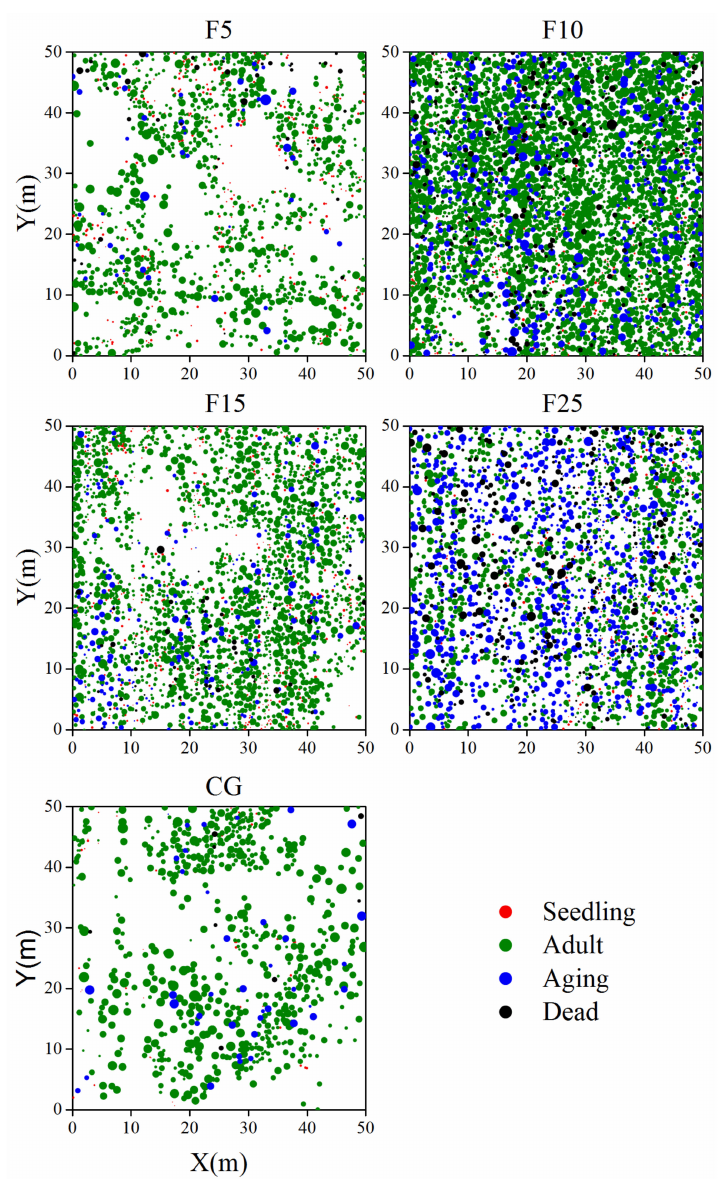
Figure 1. Maps of seeding, adult, aging, and dead A. ordosica groups in F5 (enclosed 5 years), F10 (enclosed 10 years), F15 (enclosed 15 years), F25 (enclosed 25 years), and CG (continuously grazed) plots. Symbol sizes represent the crown of